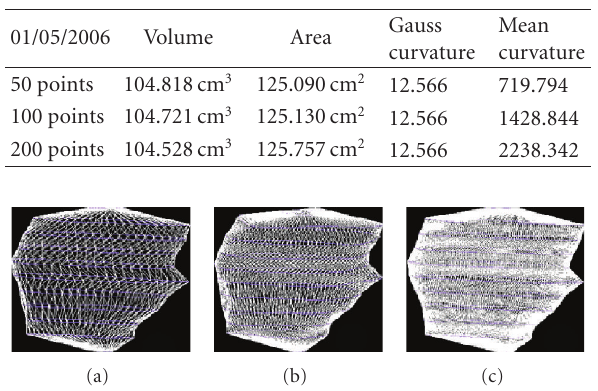
Figure 30: Patient 3. (a) 50 points on the contours, (b) 100 points on the contours, and (c) 200 points on the contours.